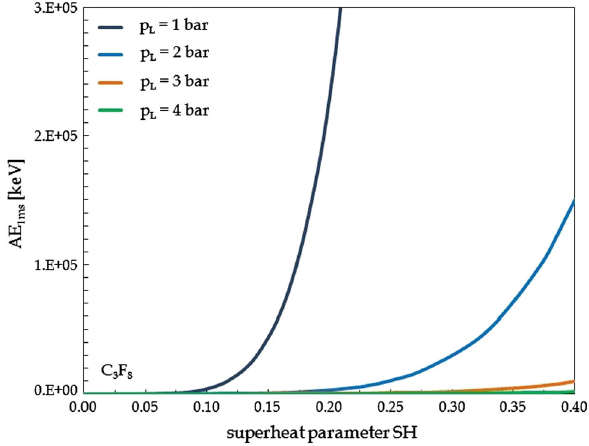
Fig. 9 Distributions of AE 1ms vs. SH for R114 and R125 using p L as a